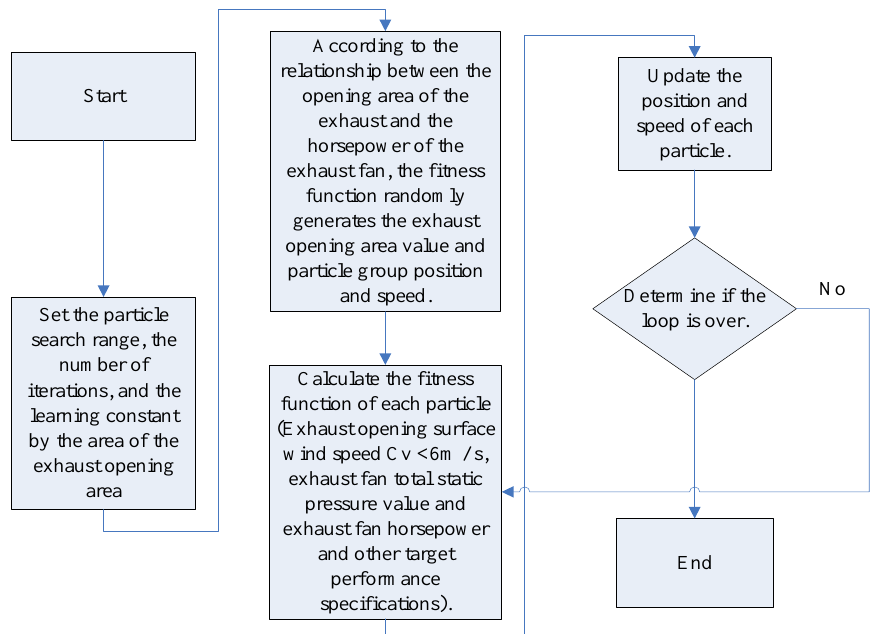
Figure 3. Optimized design flowchart for the equipment room outlet opening area and the exhaust fan horsepower.